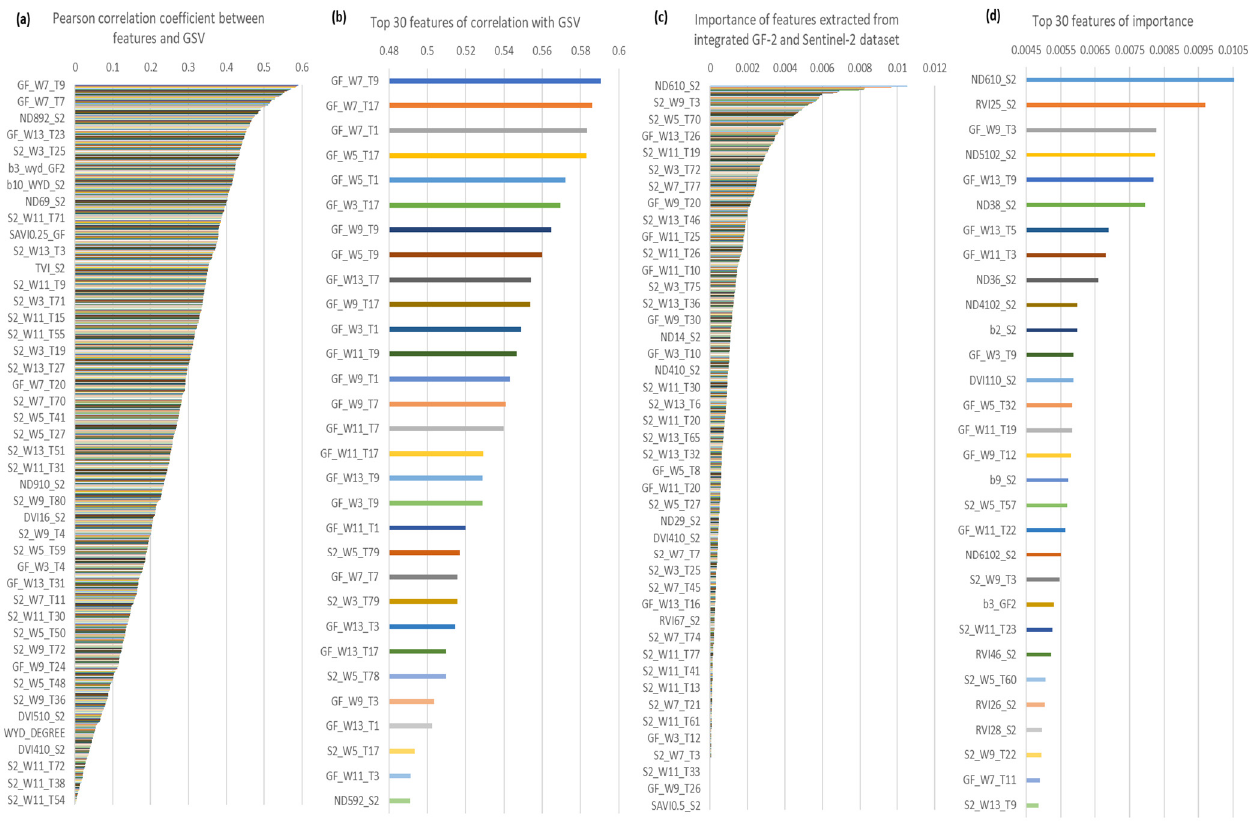
Figure A2. ( a , b ), the Pearson correlation coefficient between GSV and 864 features extracted from integrated GF-2 and Sentinel-2 dataset. ( c , d ),the importance of features. GF, GaoFen-2, S2, Sentinel-2, W, the size of the window, T, Serial number of texture feature variables based on band number and texture feature number sequential connection, for example, the eighth texture feature of the second band image can be denated as T16.